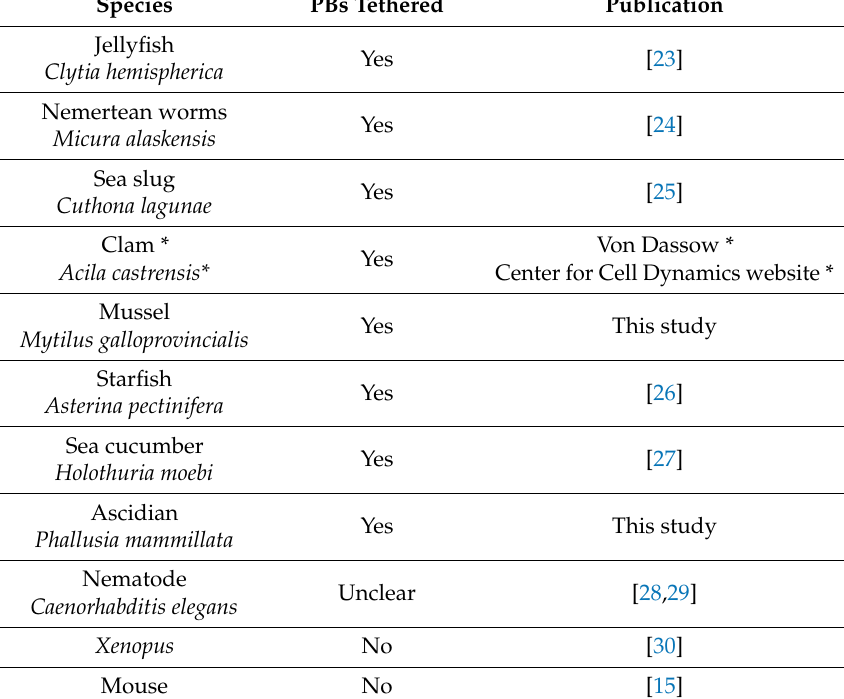
Table 1. Tethered polar bodies. Several species display tethered first and second polar bodies as in the ascidian and depicted in Scenario 1. This is not an exhaustive list since we noted several other examples that are not detailed here. Notable exceptions are the vertebrates that do not show tethered polar